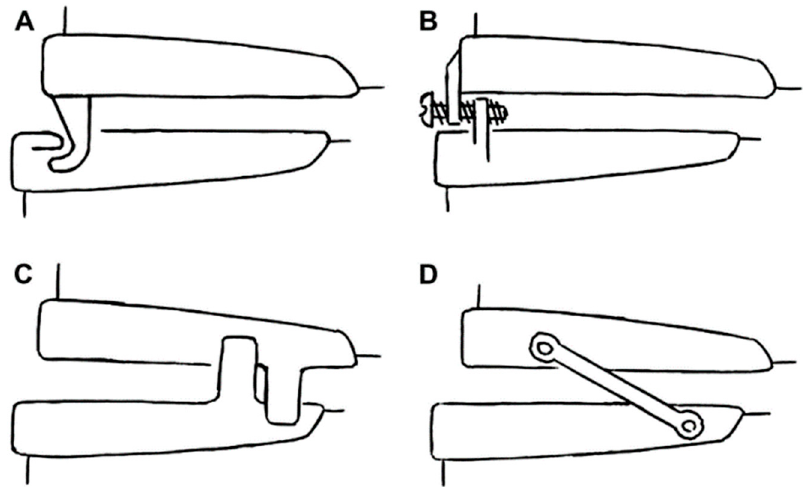
Figure 1. Schematic overview of titratable, duobloc mandibular advancement device (MAD) designs used in current clinical practice: ( A ) MAD with an anteriorly articulating component that allows the MAD for adjustment of the appliance; ( B ) MAD with attachments for the adjustment of mandibular protrusion in the frontal teeth area; ( C ) MAD with two lateral positioning attachments that permit incremental protrusion of the mandible; ( D ) MAD with lateral telescopic rods that force the mandible into an anterior position.(Figure published in Dieltjens et al., 2012 [31]).